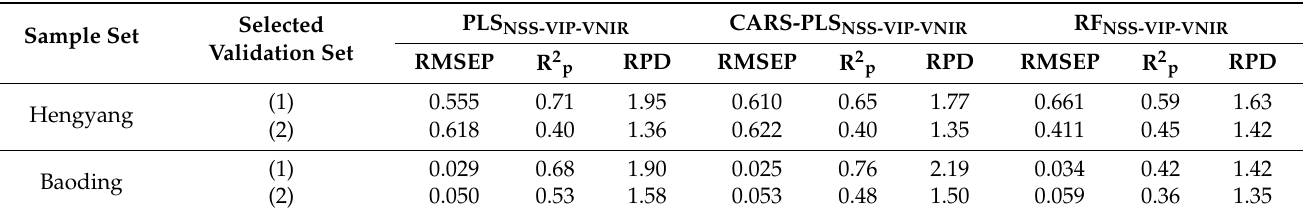
Table A3. Supplyment result of RF model while the validation set was selected (1) every 1 in 5 samples with the ascending sorted Cd concentration; (2) Kennard-Stone algorithm (1/5 of sample